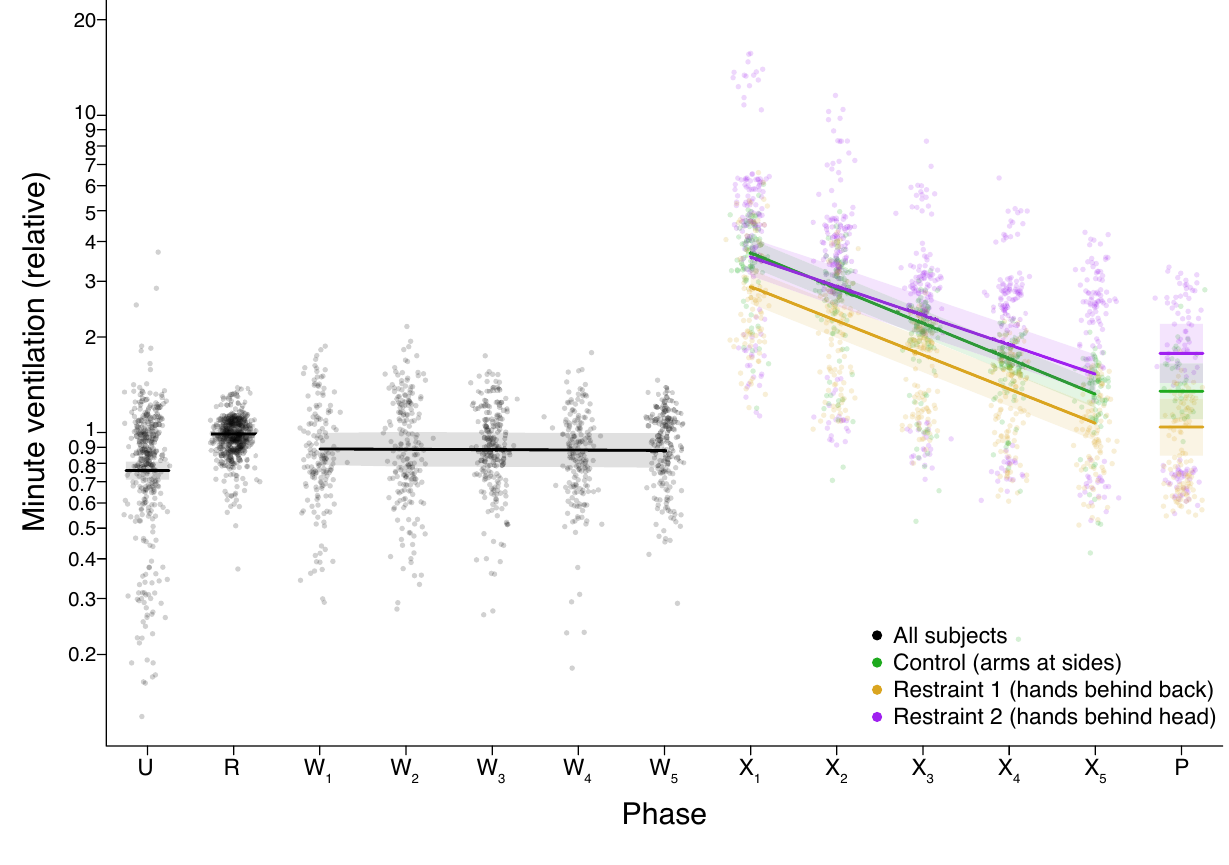
˙ V ˙ V Figure 3. Minute ventilation ( E ), expressed as a ratio of the mean E in phase R, shown on a ln scale. Each ˙ V datapoint represents the E for an individual breath. The solid lines are predicted means derived from the statistical analyses assuming the average age and BMI. The shaded regions show the 95% confidence interval on these model predictions. Postures were either a control posture identical to that of phase W, with arms at the side (N = 5), hands clasping each other on the small of the back (N = 6), or both hands on the back of the head (N = 6). Note that in phase P, the number of subjects was reduced to only N = 1 (control), N = 3 (hands-back) and N = 3 (hands-head).